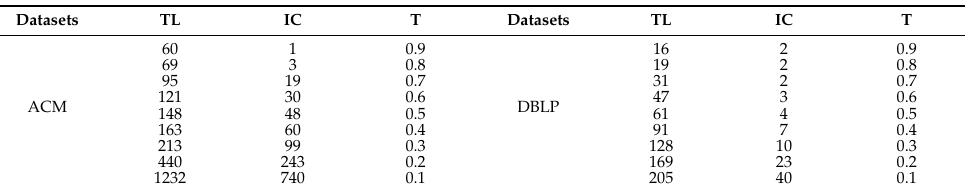
Table 5. Statistics of node labels consistency on ACM and DBLP datasets under trace equivalence. TL: number of total nodes appear in trace equivalence classes, IC: number of nodes whose label is inconsistent in their trace equivalence class, T: threshold.